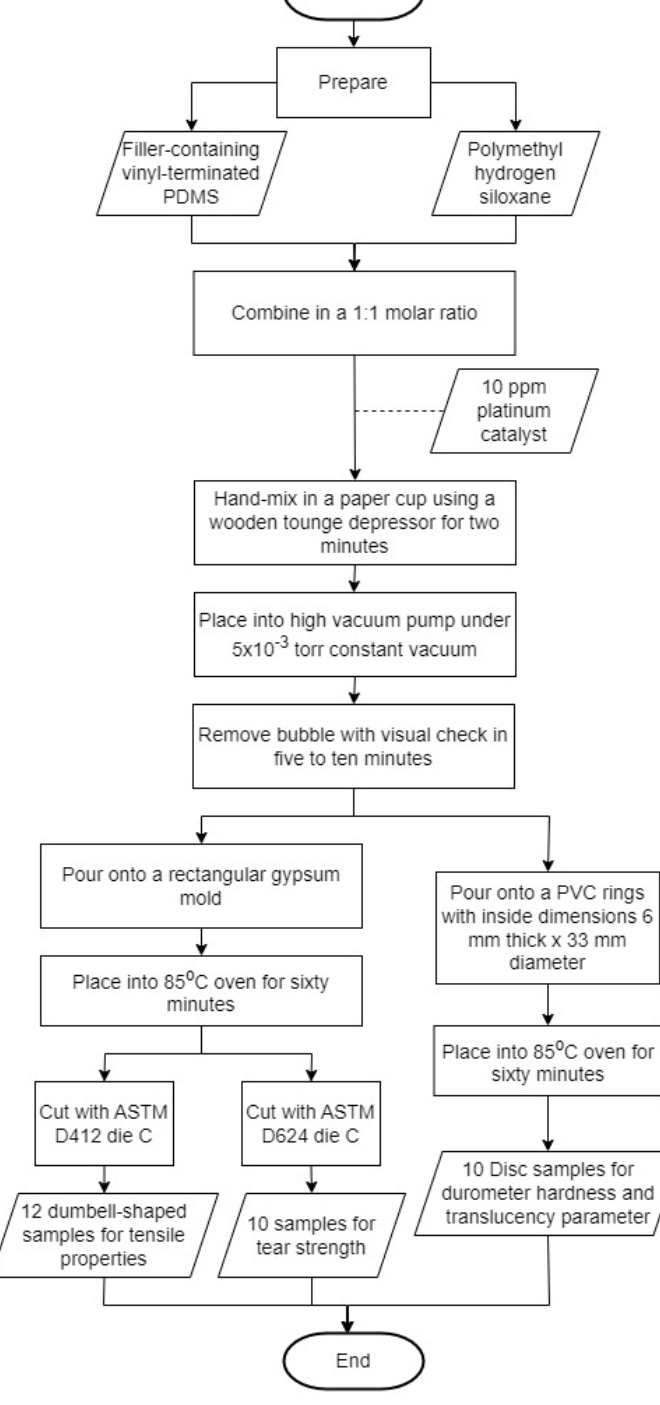
Figure 1. Sample preparation flowchart.